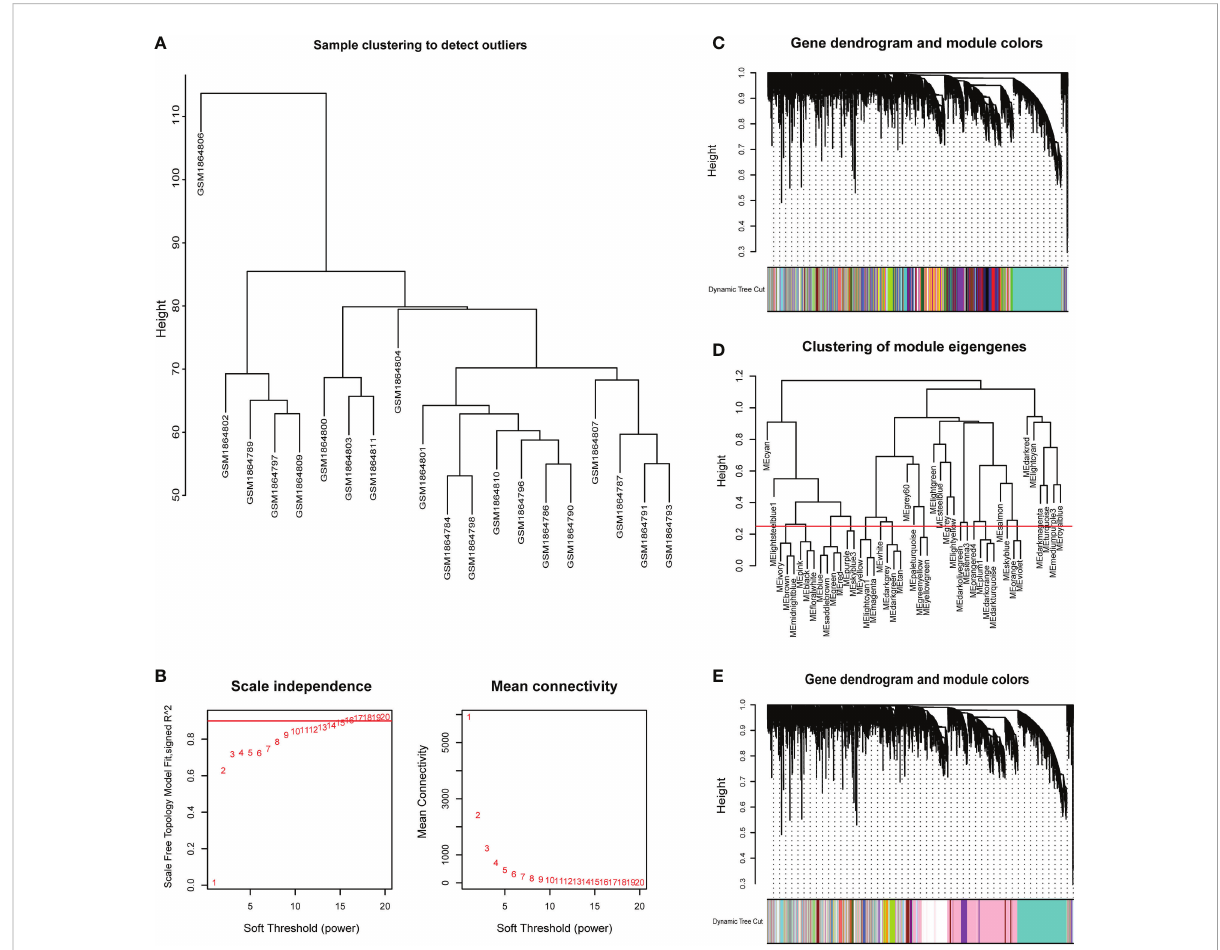
FIGURE 4 Sample dendrogram and clustering dendrogram of WGCNA. (A) Cluster samples to detect outliers. (B) Plot scale-free topology to determine soft threshold (power). (C) The identi fi ed co-expression modules and the dendrogram. (D) Set the criteria to merge similar modules. (E) The dynamic cut tree after merging